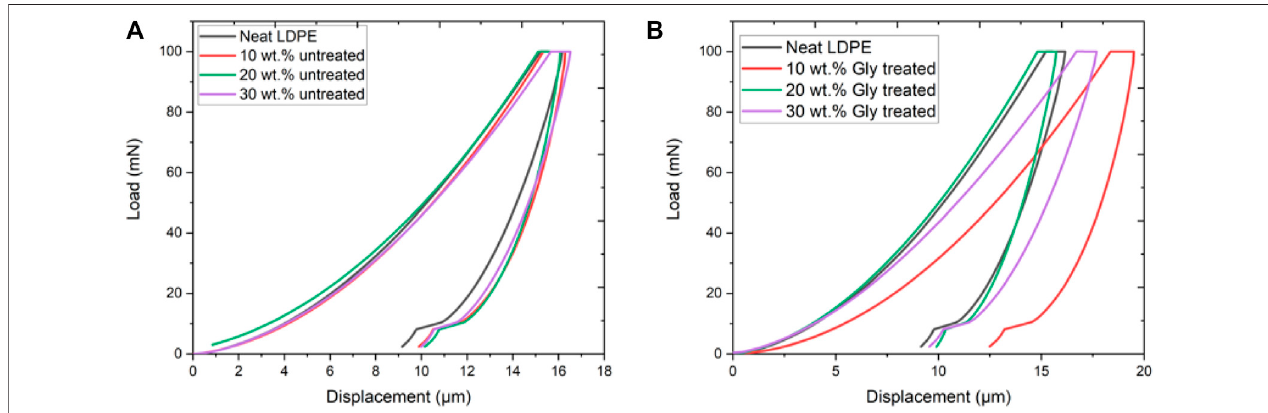
FIGURE 5 | Compliance curves of biocomposites with different biomass loadings at a maximum loading of 100 mN: (A) untreated RH reinforced biocomposites; (B) Gly-treated RH reinforced biocomposites.